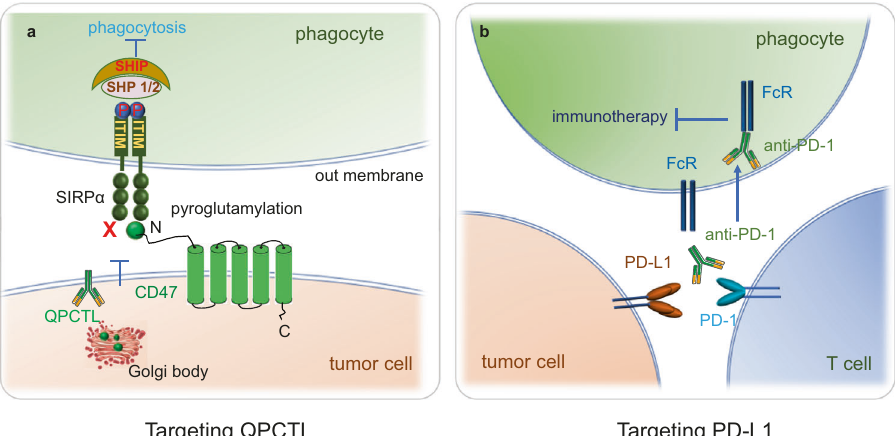
Fig. 7 Targeting QPCTL and targeting PD-L1. a QPCTL is the key enzyme for pyroglutamylation of CD47. Targeting QPCTL signi fi cantly reduces the binding ability of CD47 to SIRP α and prompts phagocytosis of tumor cells by macrophages thus regulating tumor immunity. b PD-1 is expressed on T cells, the antibody targeting PD-1 can bind to FcR on phagocytes and then be engulfed by the phagocytes, leading to the inhibition of cancer immunotherapy Signal Transduction and Targeted Therapy (2023)